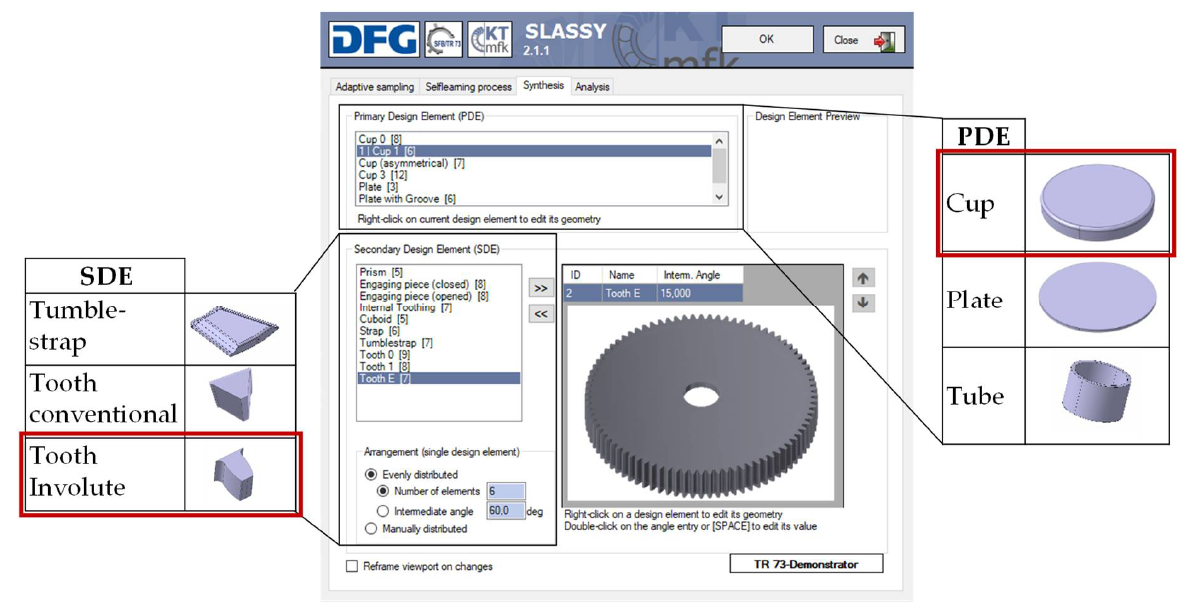
Figure 2. Part design and the synthesis step within SLASSY.